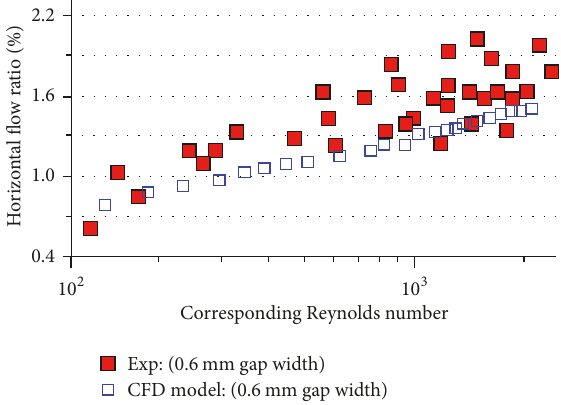
Figure 11: CFD model versus empirical results